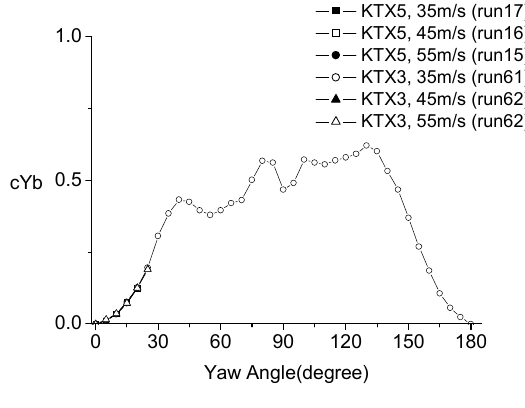
Figure 6 Side force coefficient (KTX T2-car)